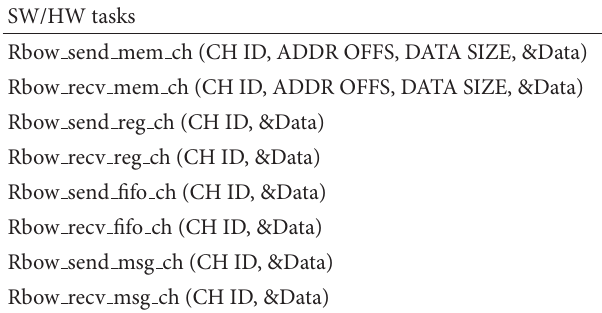
Table 2: Communication/Synchronization